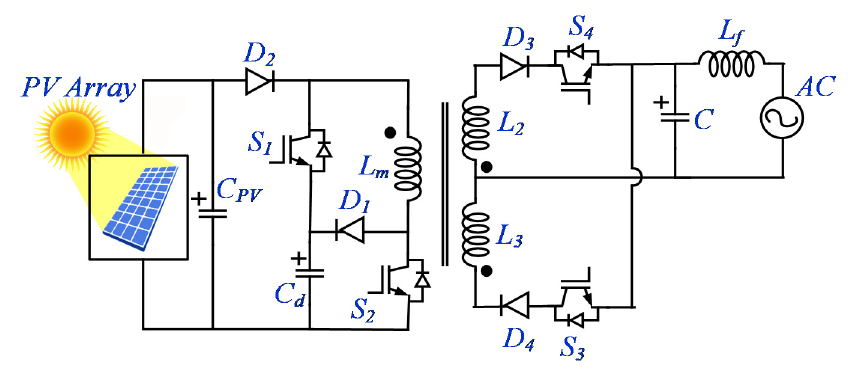
Figure 23. Three port fly-back inverter with coupling circuit-2 .